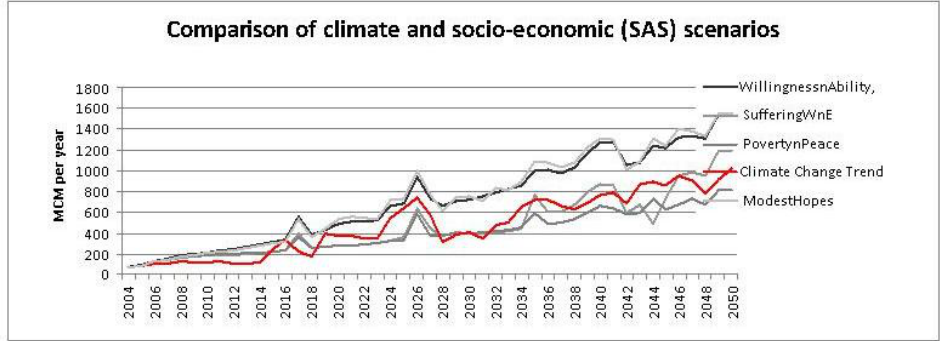
Figure 6. Projections of basin-wide annual unmet demand for four different socio-economic (SAS) scenarios and a ―middle-of-the-road‖ (SRES A1B) climate scenario. The four socio-economic scenarios depicted in Figure 6 stand for the four different combinations of positive regional economic development vs. economic recession and regional collaboration vs. unilateral